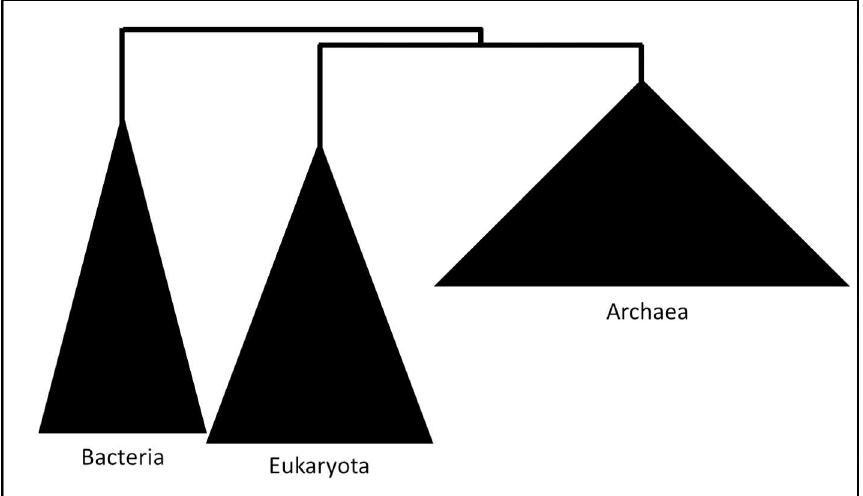
Fig 3. Maximum-likelihood phylogenetic tree of the NusG protein. All archaeal NusG sequences were taken from the GenBank database, along with their most similar bacterial and eukaryotic homologs for a total of 500 protein sequences. The bootstrap consensus tree inferred from 100 replicates was taken to represent the evolutionary history of the taxa analyzed. Branches were merged at the domain level.